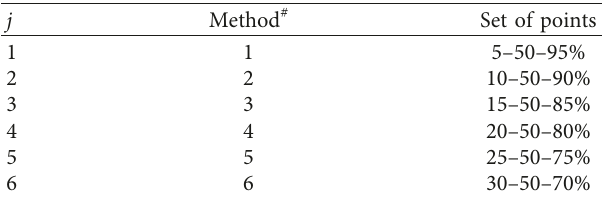
Table 12: Set of symmetrical points used for FFOPDT model